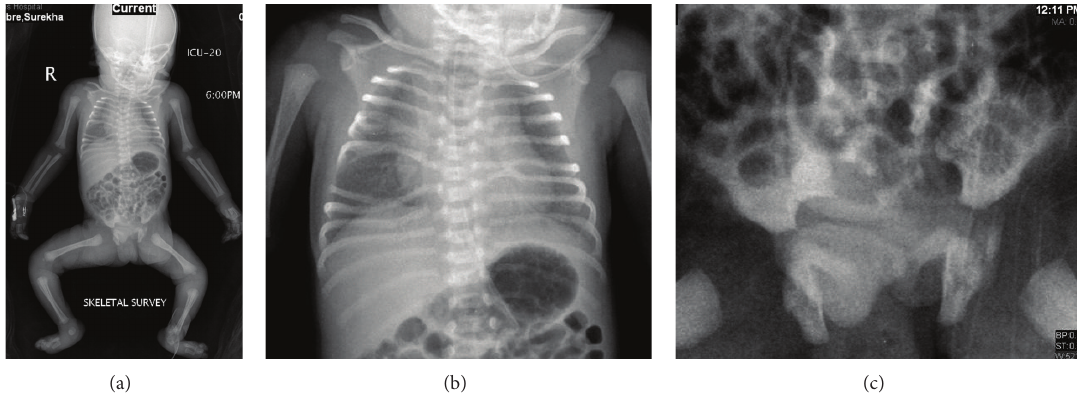
Figure 1: Babygram (a) and magnified chest area (b) and pelvic area (c); there is abnormal orientation of the ribs with splitting of right 5th and 6th ribs and absent posterior part of right 7th rib with marked splaying and spacing between 6th, 7th, and 8th ribs. Partial agenesis of the sacrum (lower segments) more involving the left side of the sacrum with associated deformity of adjacent left iliac bone and SI articulation, widening of interpedicular distance of lower dorsal and lumbar spines; no other skeletal abnormality identified.